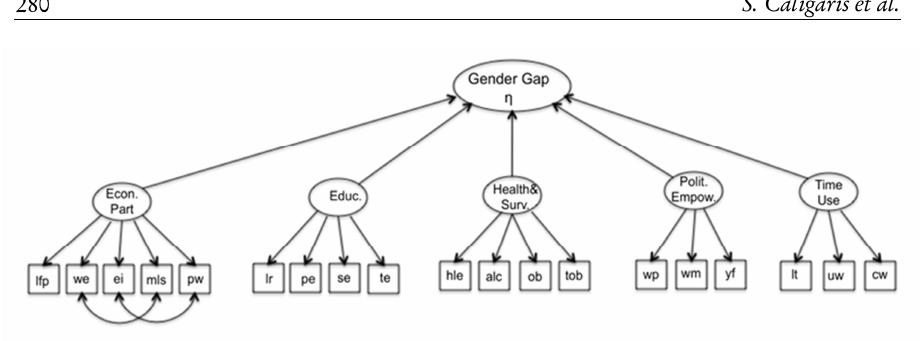
Figure 3 – Path diagram adopted for GGGI with the added Time Use component. Legend